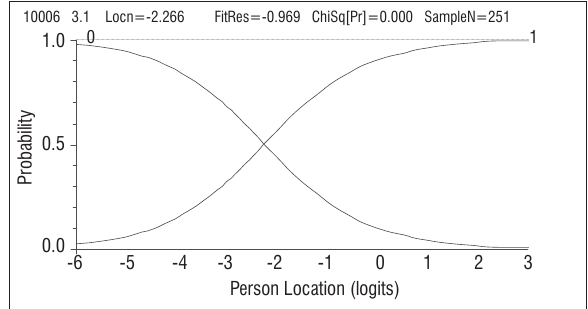
Figure 2: Category probability curve showing the probabilities of scores 0 and 1 on a single item as a function of